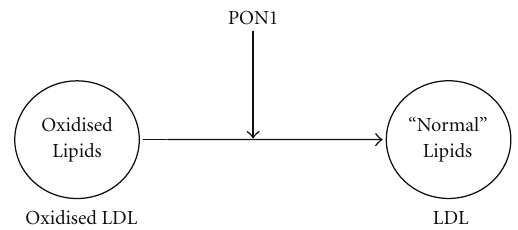
Figure 2: The antioxidant role of PON1. The main physiological role of this enzyme is to degrade oxidized phospholipids and oxidized cholesteryl esters in